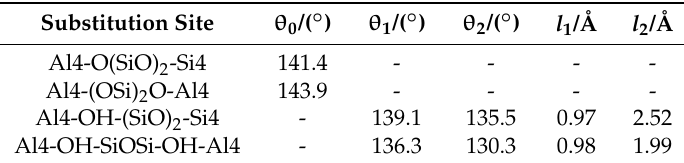
Table 3. Structure parameters of T4 ‐ O(SiO) 2 ‐ T4 1 .